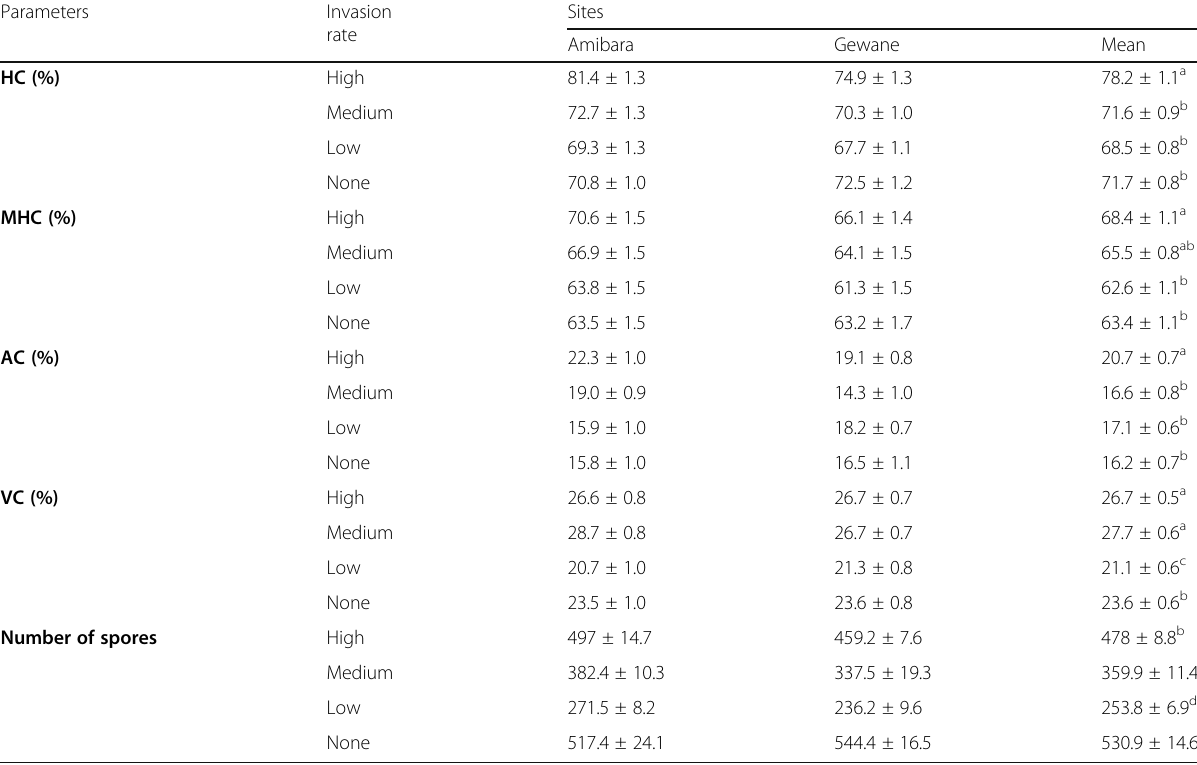
Table 4 The effect of P. juliflora invasion rates and site on AMF root colonization community structures